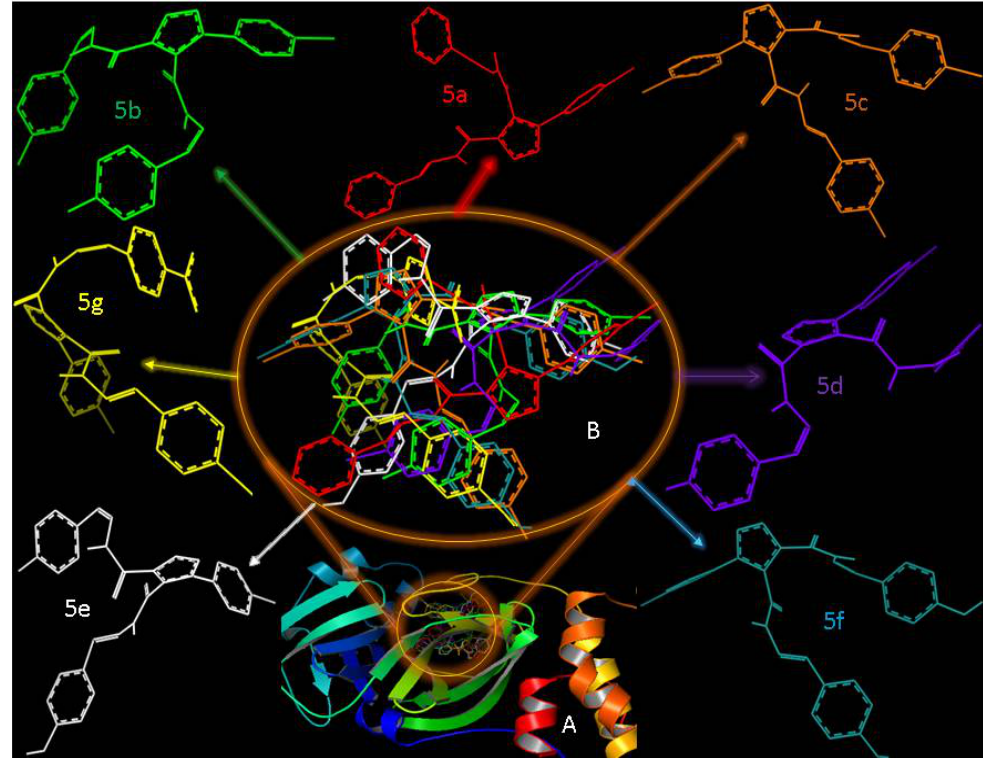
Figure 9. A: The display of the superposition of all the SBs, 5a – g , docked against 7BQY; B: the display of the ligands without the 7BQY protease surrounded by the display of each ligand as they appeared in the ligand–protein binding cavity.